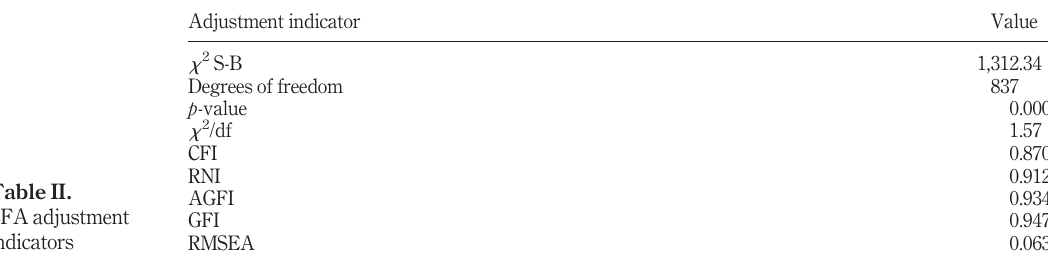
Table II. CFA adjustment